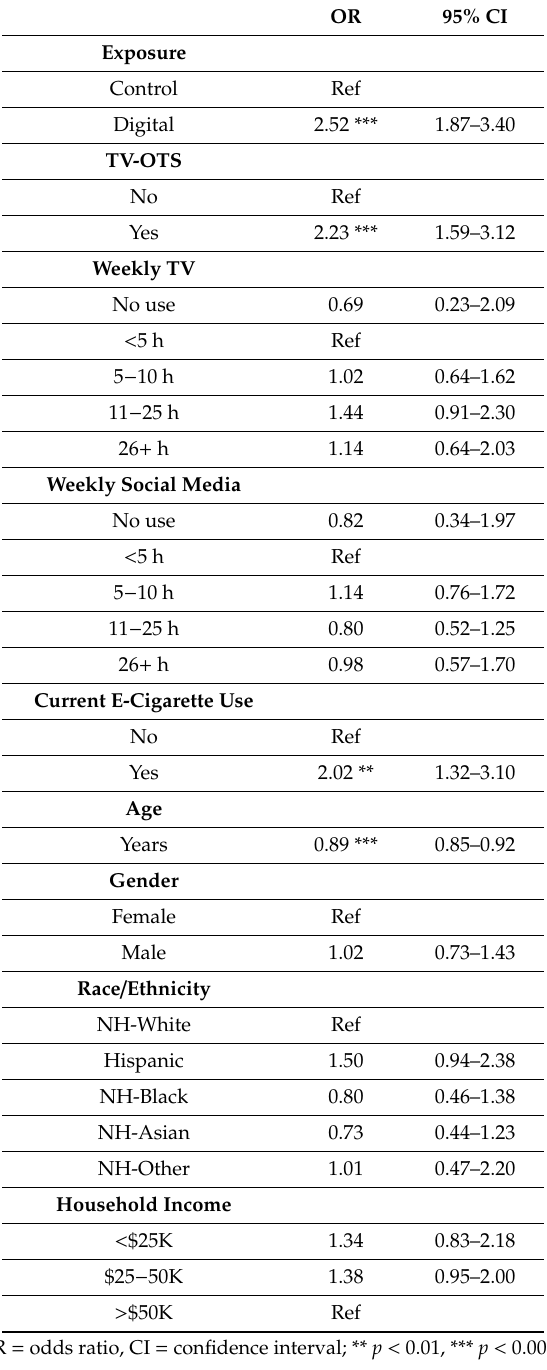
Table 2. Logistic model results predicting binary ad